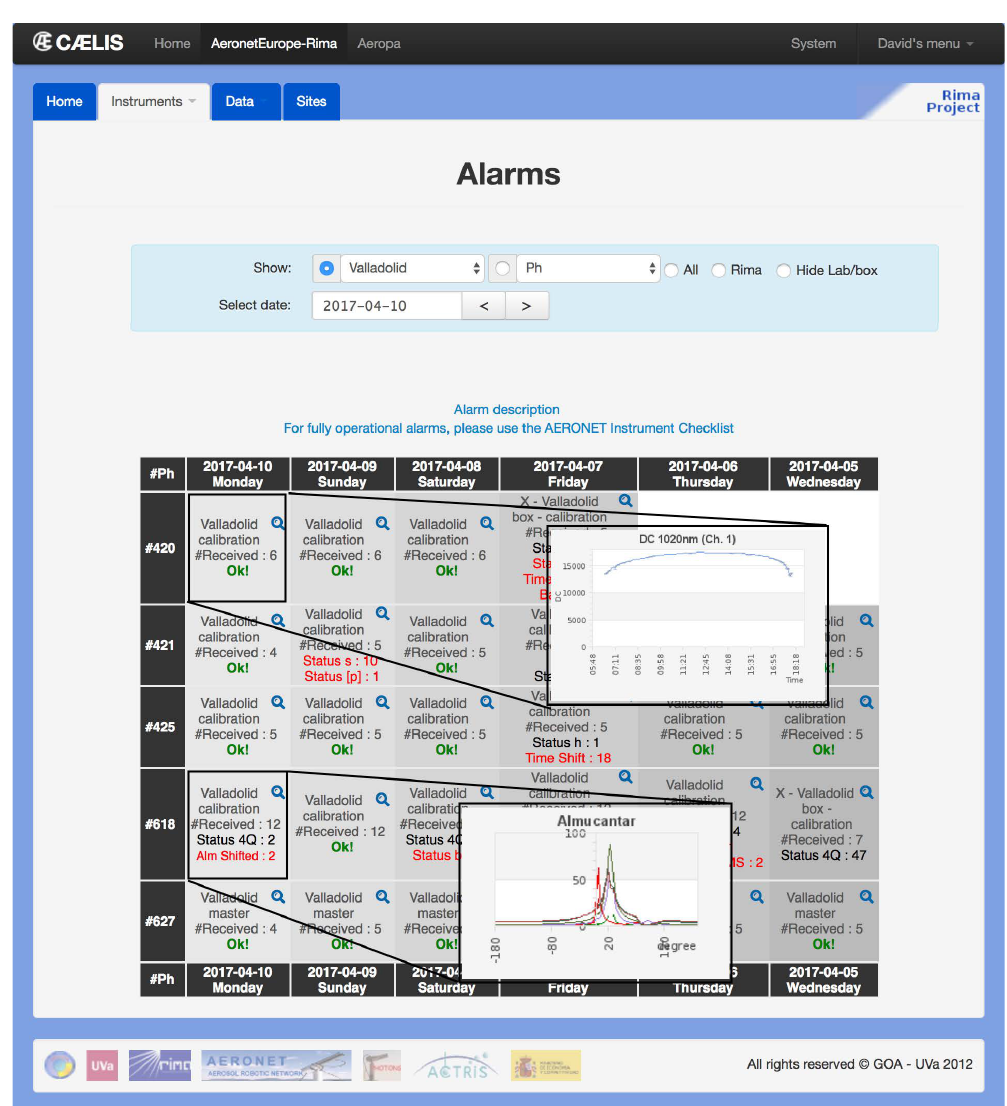
Figure 9. View of real-time flags (alarms) for a specific day at Valladolid site. A zoomed-in view shows how the signal of a good day appears and how a problem is automatically identified. Specifically, photometer #618 on 10 April 2017 has an almucantar where the sun is not in the center (usually from cable